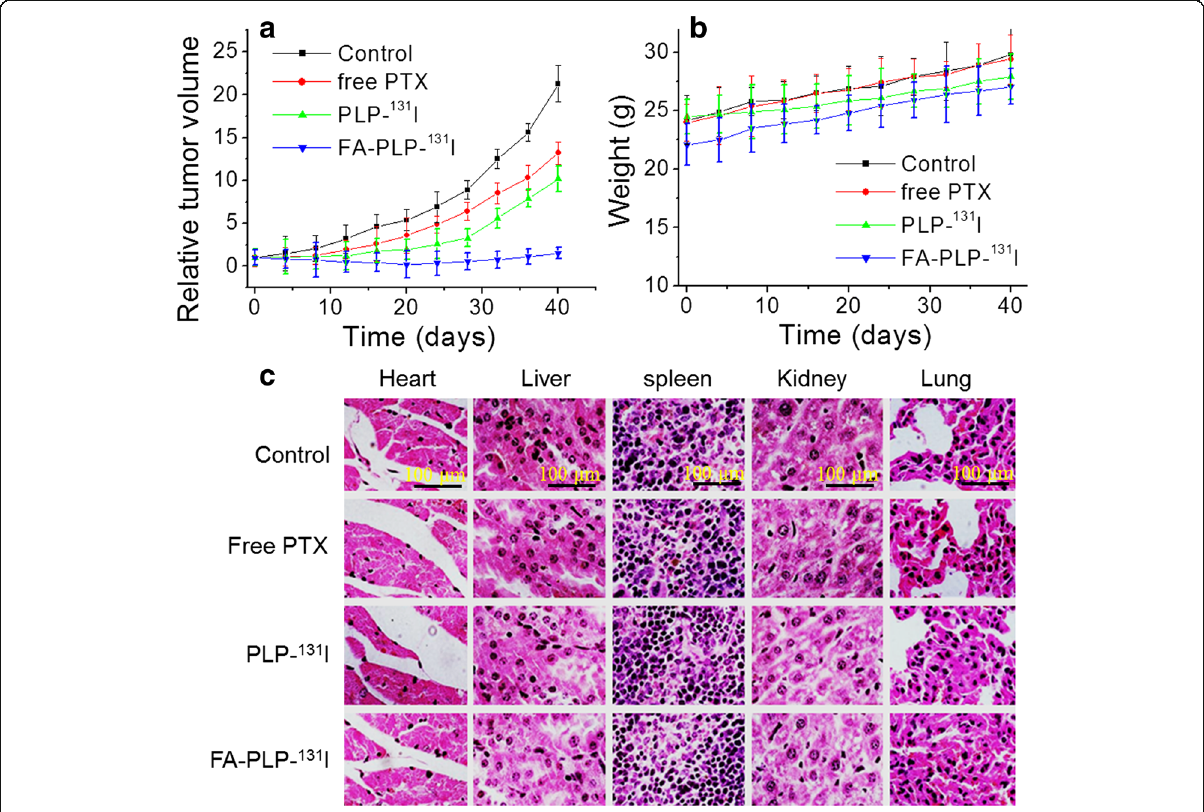
Fig. 7 a The relative tumor volume and b body weight of tumor-bearing mice after tail vein injection with saline (control), free PTX, PLP- 131 I, and FA- PLP- 131 I. b Body weight of tumor-bearing mice after tail vein injection with saline (control), free PTX, PLP- 131 I, and FA- PLP- 131 I. c The representative hematoxylin and eosin staining images of major organs including the heart, liver, spleen, lung, and kidney. Scale bar =100 μ